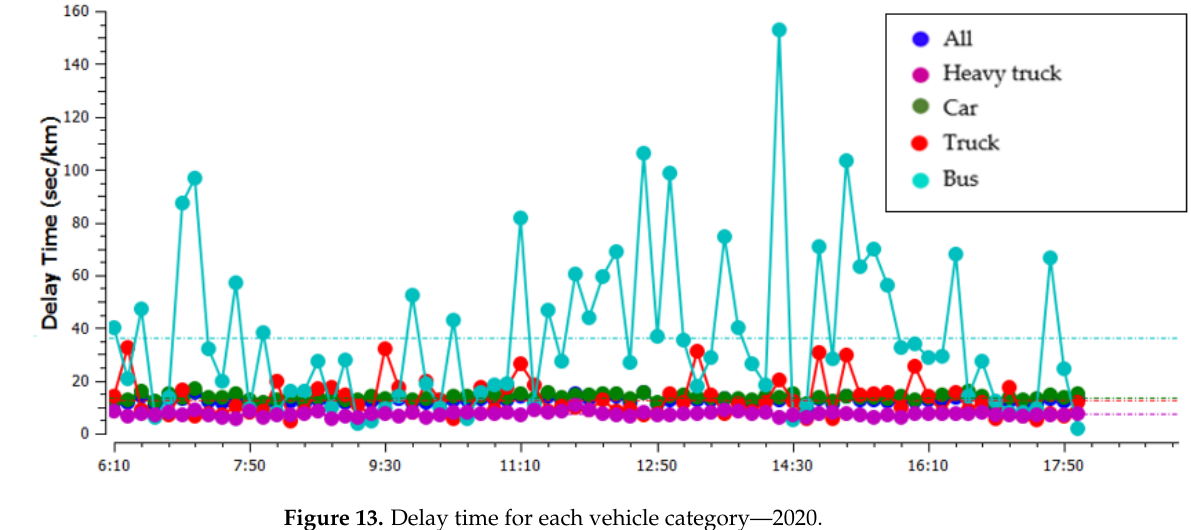
Figure 13. Delay time for each vehicle category—2020.